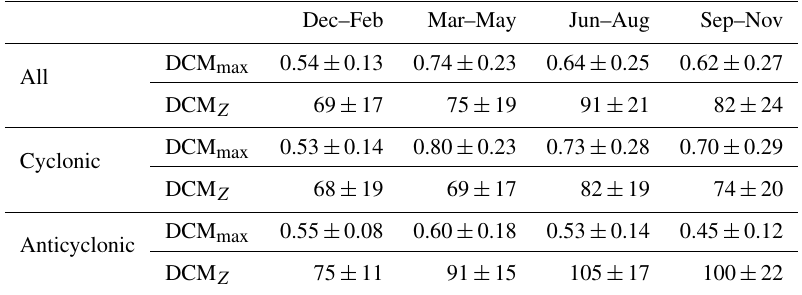
Table 2. Seasonal mean and standard deviation of the phytoplankton maximum (DCM max , in mgm − 3 ) and the depth of the phytoplankton maximum (DCM Z , in meters). Values were obtained by considering only profiles for which the MLD is shallower than the